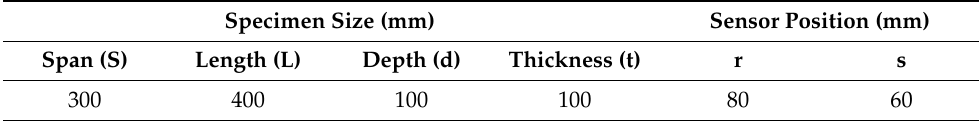
Figure 1. Configuration of the four-point bending specimen and sensors. Table 1. Specific dimensions of the specimen and sensors.